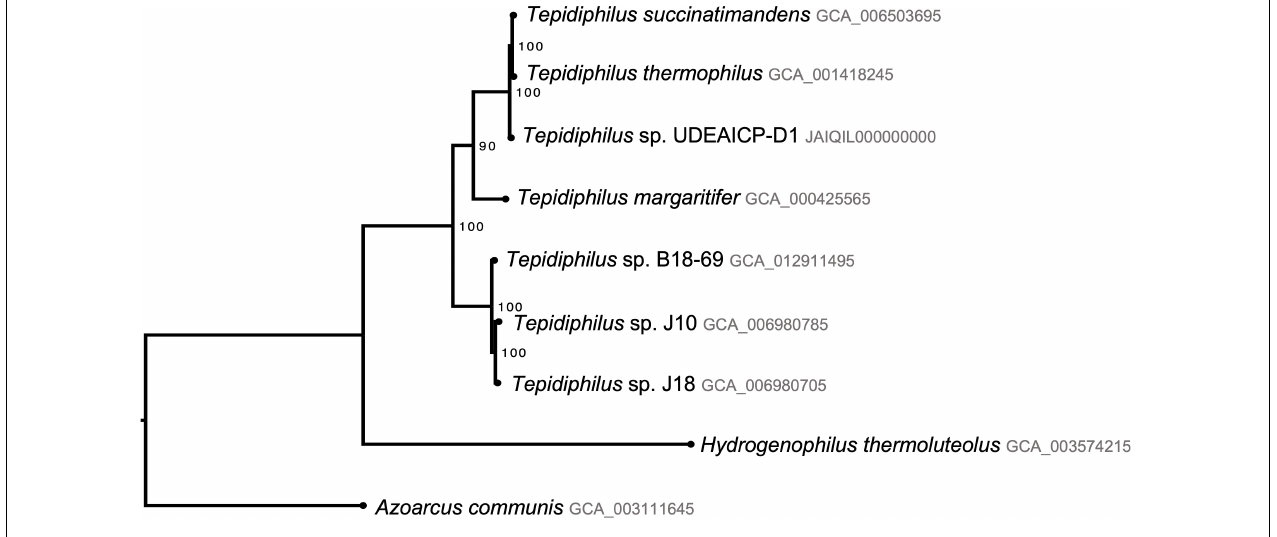
FIGURE 5 | Phylogenomic analysis of the Tepidiphilus species based on 26 single copy conserved protein-coding genes. Maximum likelihood tree with 1,000 pseudoreplicates of ultrafast